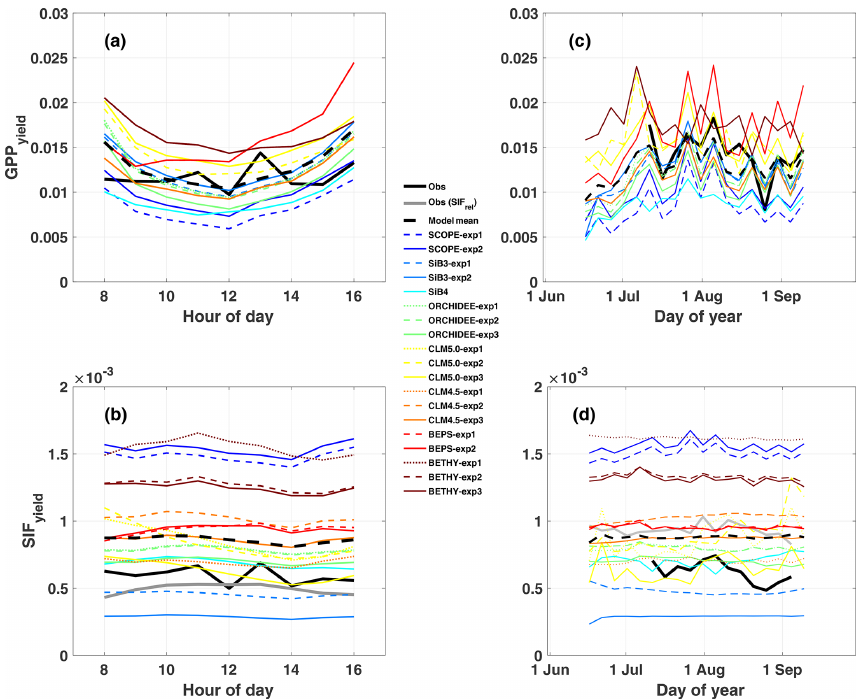
Figure 3. Same as Fig. 2 except for SIF yield and GPP yield . Here, SIF yield = SIF canopy /APAR, and GPP yield = GPP/APAR. As with Fig. 2, the left column shows the mean diurnal cycle, and the right column shows a time series of 5d averages.